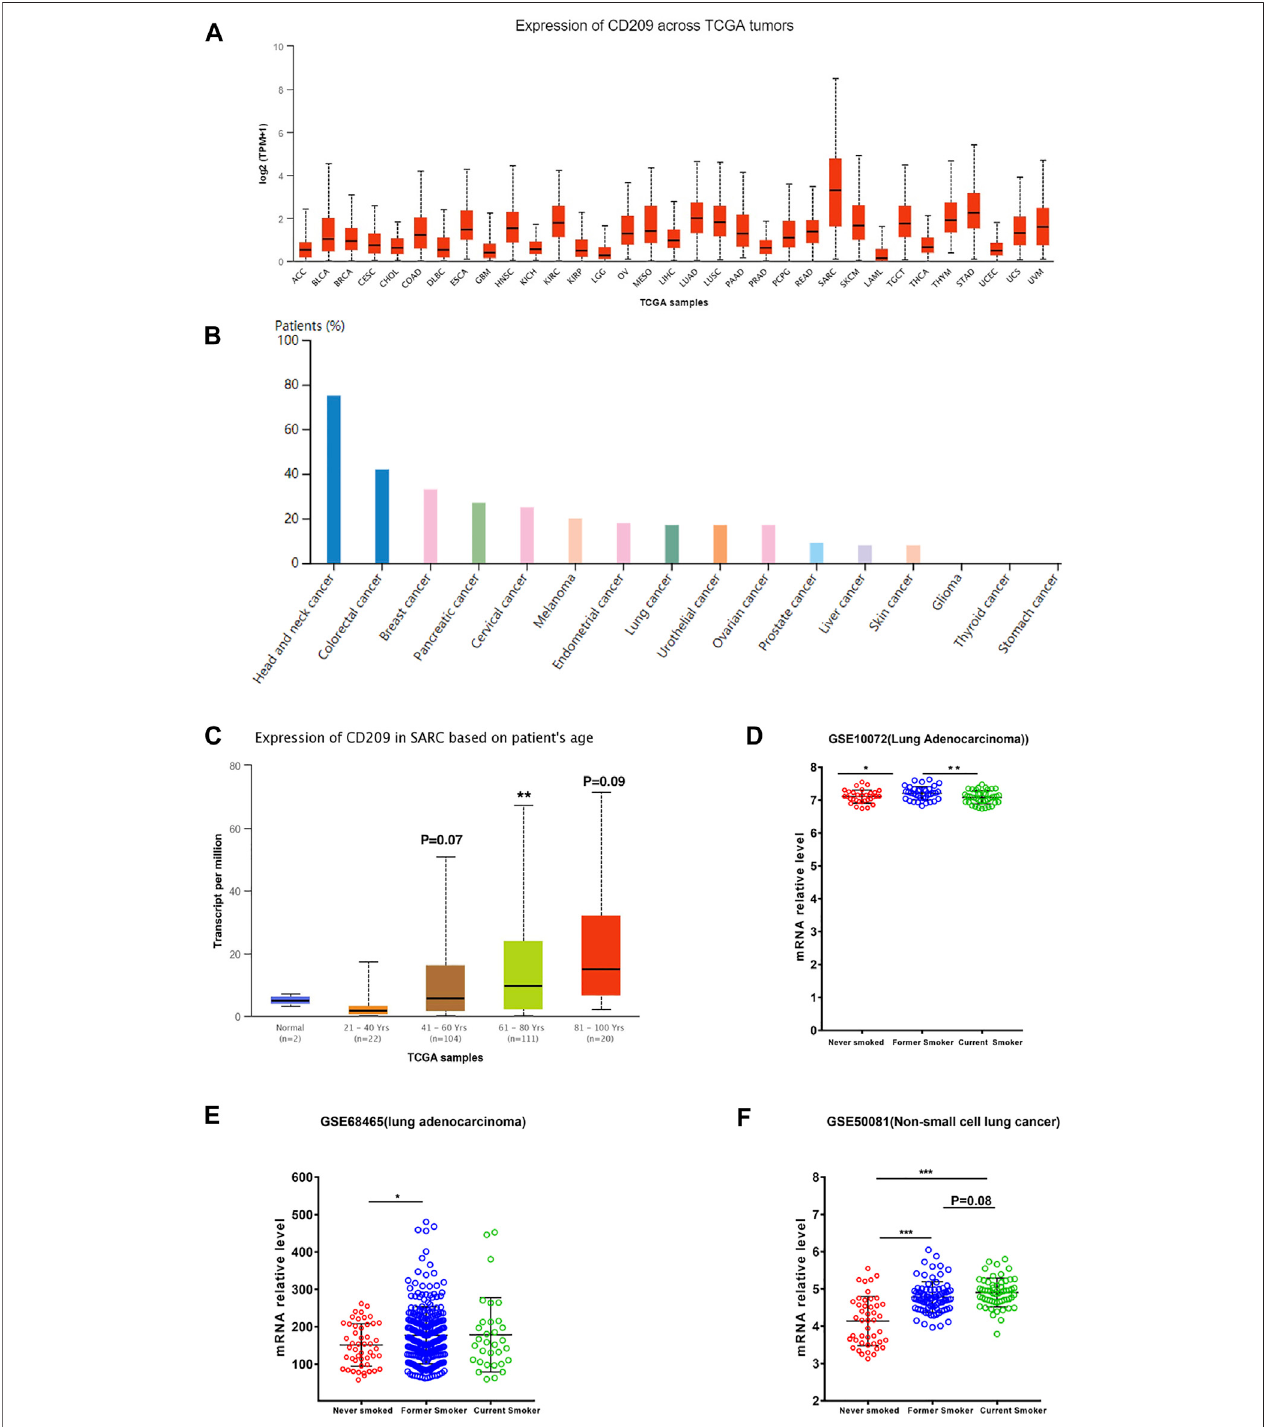
FIGURE 2 | Expression pro fi le of CD209 in pan-cancers. (A) RNA expression level of CD209 in pan-cancers in the TCGA dataset. (B) Protein expression level of CD209 in pan-cancers in CAB045970 dataset. (C) Expression of CD209 increased in SARC patients associated with patient ’ s age. (D) Expression of CD209 was upregulatedinformersmokerswithLUADindatasetGSE10072( n =58). (E) ExpressionofCD209wasupregulated informersmokerswithLUADindatasetGSE68465 ( n = 322). (F) Expression of CD209 was upregulated in former smokers and current smokers with LUSC in dataset GSE50081 ( n = 160). Data are represented as mean ± SD. * p < 0.05, *** p < 0.01, *** p < 0.001(Student ’ s t-test). Abbreviation: SARC, sarcoma.